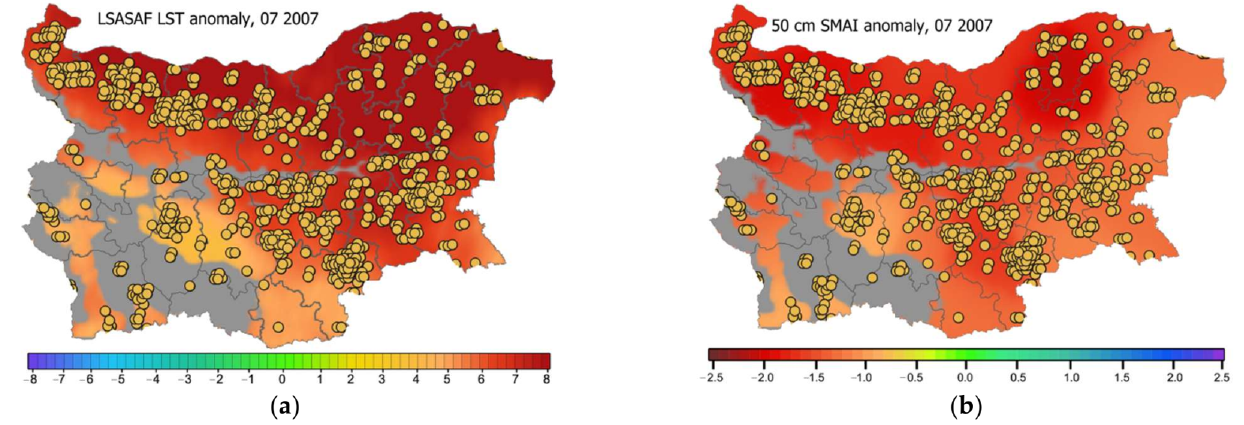
Figure 2. Spatial distribution of LSASAF FRP fire pixel detections superimposed over: ( a ) LSASAF LST 0900 UTC anomalies and ( b ) monthly mean SMA anomalies (50 cm soil depth). Examples for